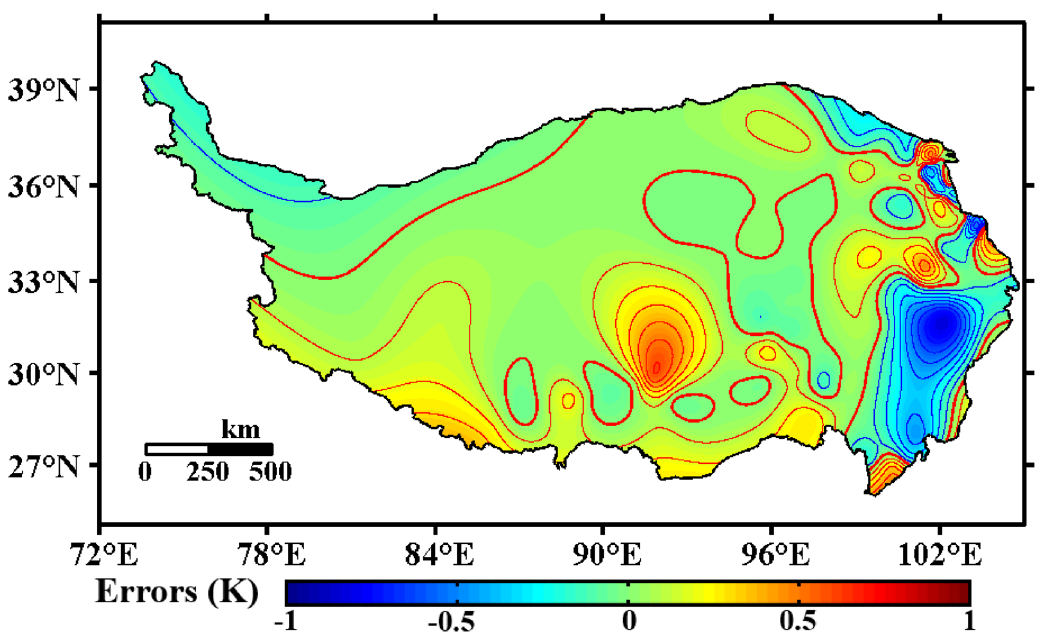
Figure 11. Errors of the “moving surface spline interpolation algorithm based on Green’s function” (annual average of 1981–2020, unit: K, Software: MATLAB 2014, https:// ww2. mathw orks. cn/ produ cts/ matlab. html).